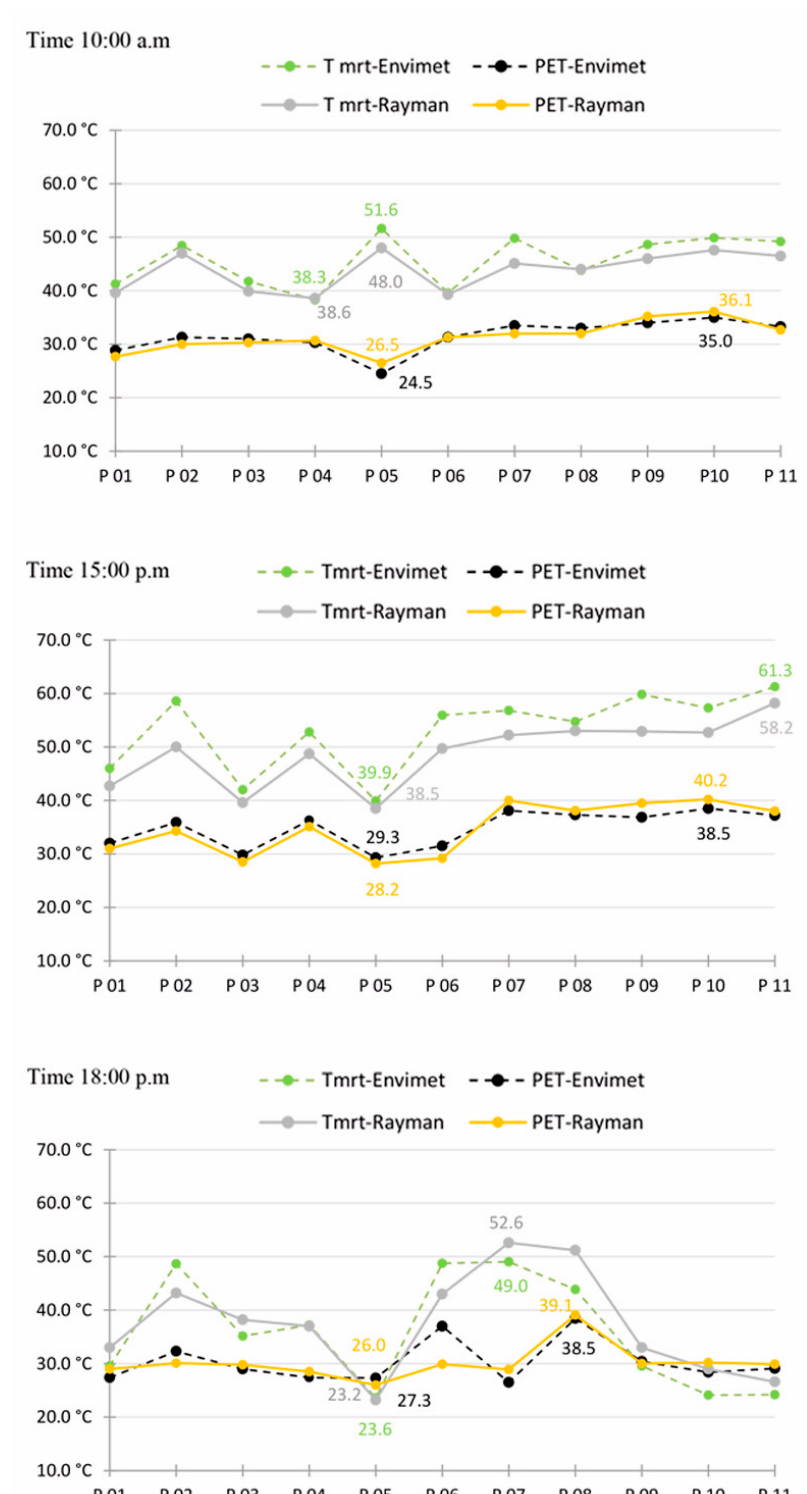
Figure 5. The verification evaluation and comparison of microspecific points between the thermal sensation T mrt and the thermal comfort index PET, z = 1.80 m. sensation T mrt and the thermal comfort index PET, z